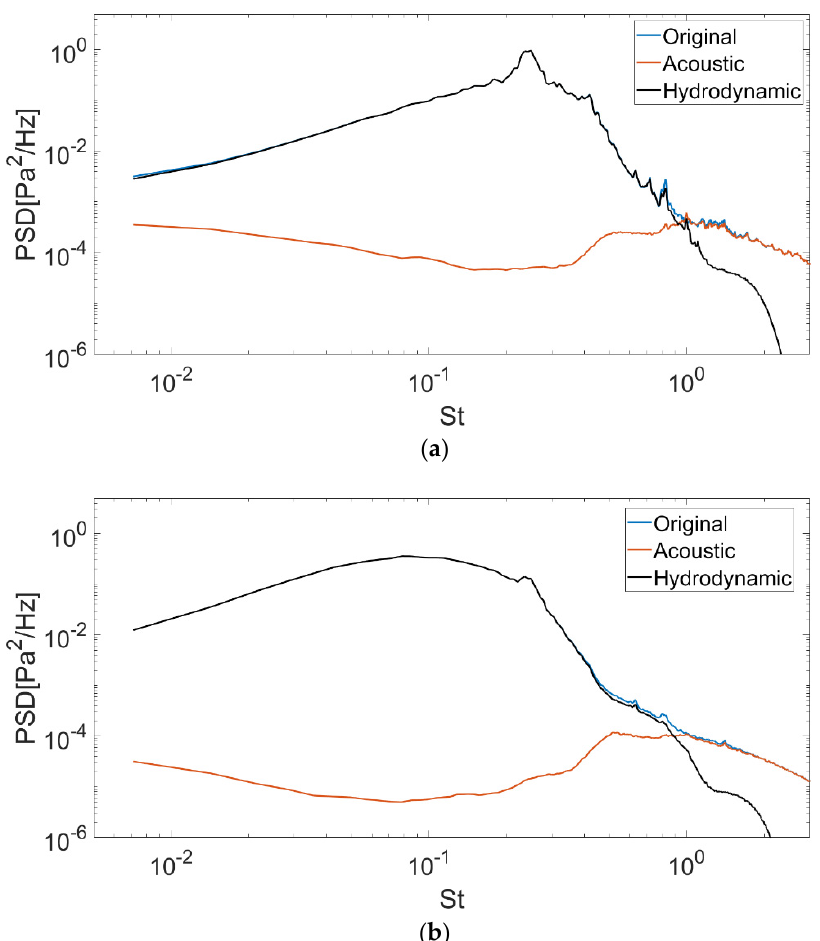
Figure 5. Examples of acoustic–hydrodynamic pressure separation achieved by applying the method WT3 of [22]: ( a ) x/D = 3, r/D = 1, M = 0.5; ( b ) x/D = 8, r/D = 1, M = 0.5.